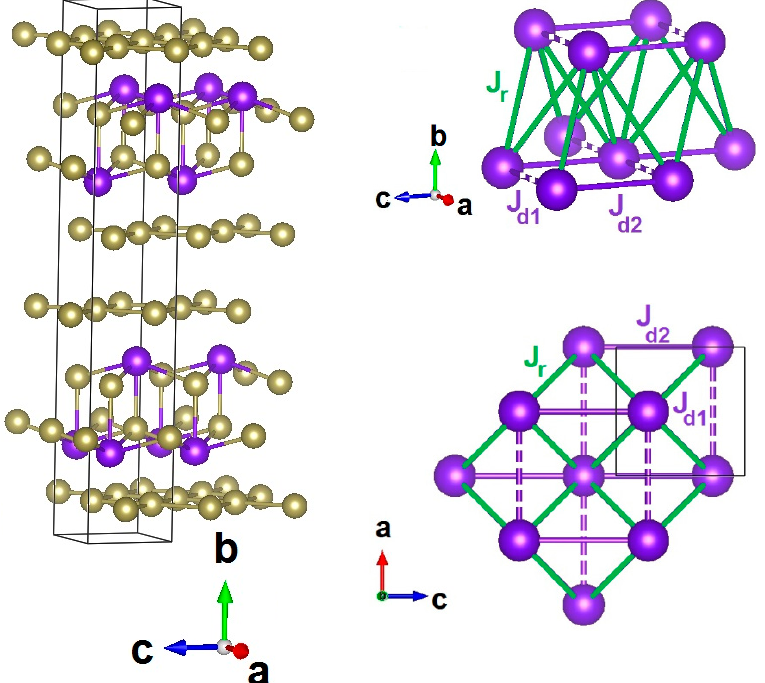
Figure 1. ( Left panel ): Crystal structure of TbTe 3 . Large and small spheres represent Tb and Te atoms. ( Upper and Lower right panels ): Three-dimensional net and ac projection of corrugated Tb—Te bilayer. Green, blue, solid, and dotted lines denote dipolar magnetic exchange interaction pathways along the rungs J r and diagonals J d 1 and J d 2 .